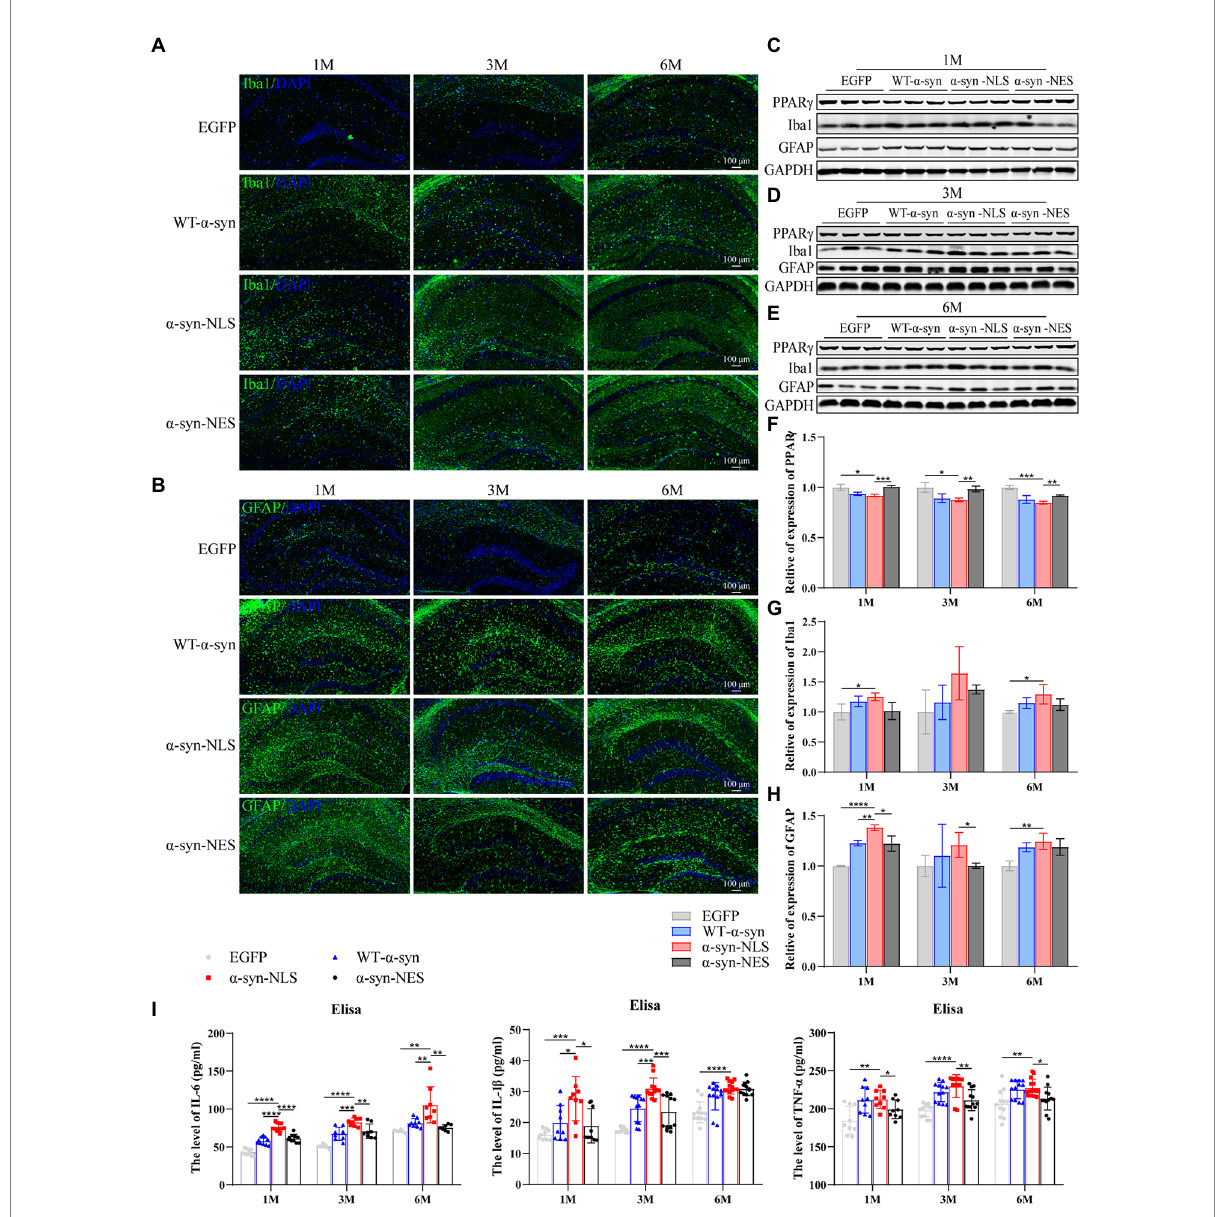
FIGURE 9 Nuclear localization α -syn increase astrogliosis in hippocampus and induces inflammatory response. (A) Immunofluorescence staining of mouse hippocampus with Iba1 (green) antibody at months 1, 3, and 6 after virus injection; DAPI was used to stain all nuclei (blue). (B) Immunofluorescence staining of mouse hippocampus with GFAP (green) antibody at months 1, 3, and 6 after virus injection; DAPI was used to stain all nuclei (blue). (C–E) Western blot of mouse hippocampus at months 1, 3, and 6 after virus injection with PPAR γ , Iba1, and GFAP antibodies ( n = 3). (F) Level of PPAR γ expression was assessed by western blot ( n = 3). (G) Level of Iba1 expression was assessed by western blot ( n = 3). (H) Level of GFAP expression was assessed by western blot ( n = 3). (I) The level of IL-6, IL-1 β , and TNF- α in the hippocampus by Elisa ( n = 9). * p < 0.05, ** p < 0.01, *** p < 0.001, **** p <